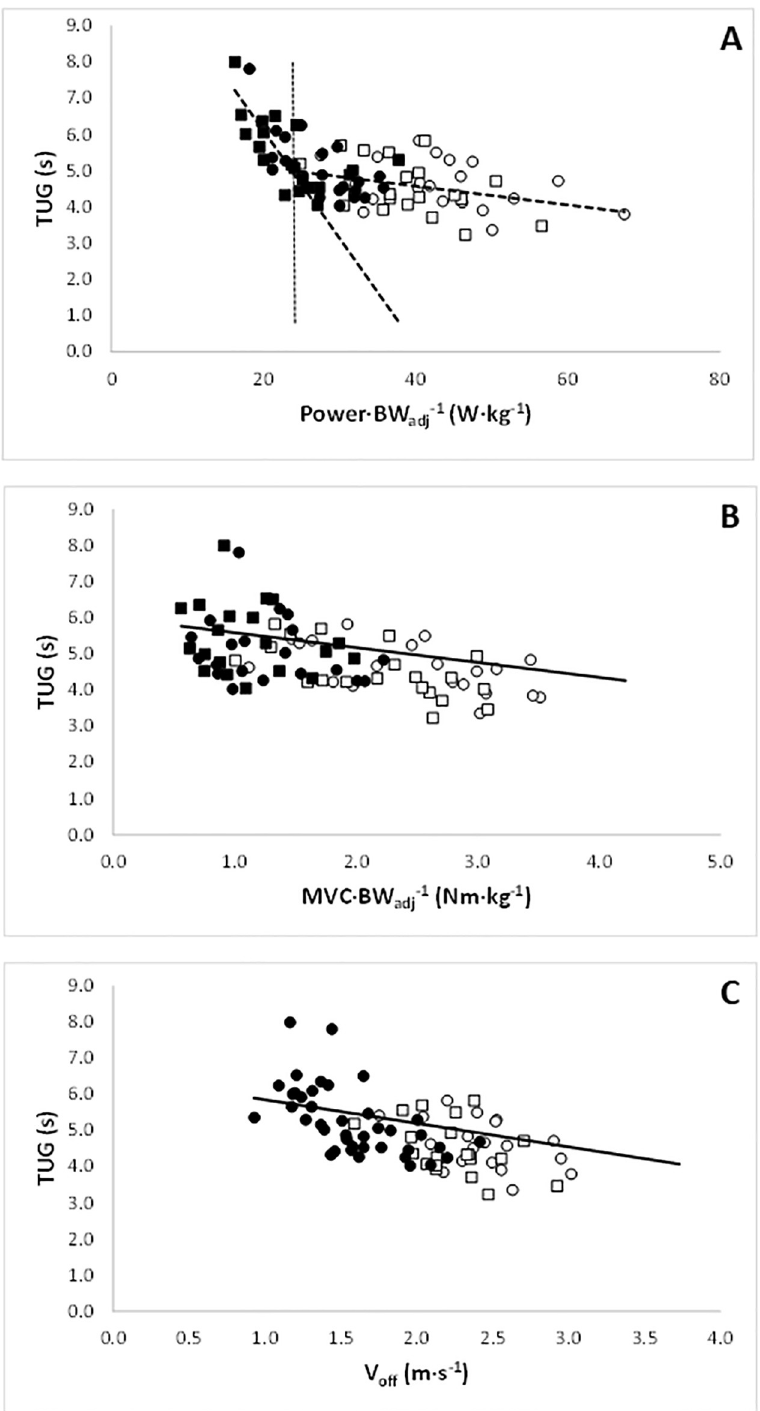
Fig 2. The Timed Up-and-Go (TUG) as a function of A) the peak power per adjusted body weight (BW adj , the weight including the harness and with or without the extra 15% body weight). The transition point occurs at 23.7 W � kg -1 (indicated by the vertical line), suggesting that if the power the muscles can generate decreases below the threshold of 23.7 W � kg -1 the TUG takes progressively longer; B) maximal isometric voluntary torque per body weight (MVC � BW adj ) ( p = 0.019) and C) take off velocity (V off ) ( p < 0.01). � : Young normal; ◻ : Young loaded; ● : Old normal; ■ : Old loaded.